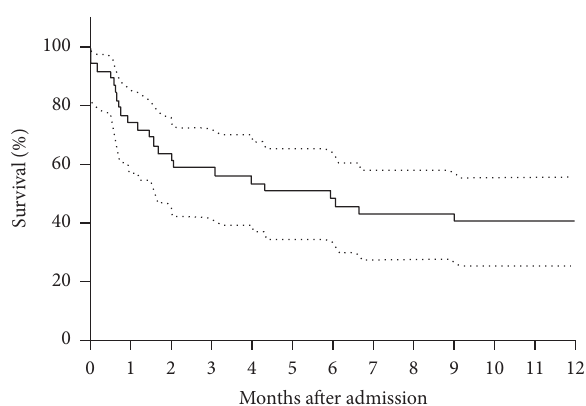
Figure 1: Twelve months’ survival using Kaplan-Meier ( 𝑛 = 39 ).